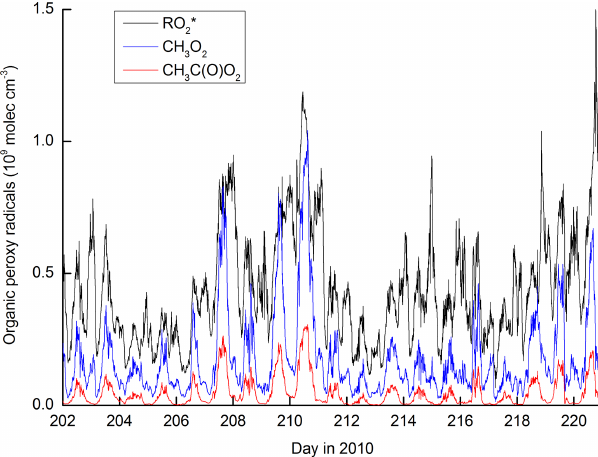
Figure 10. Modelled organic peroxy radical concentrations. RO ∗ represents organic peroxy radicals formed in the OH-initiated degradation of OVOCs and